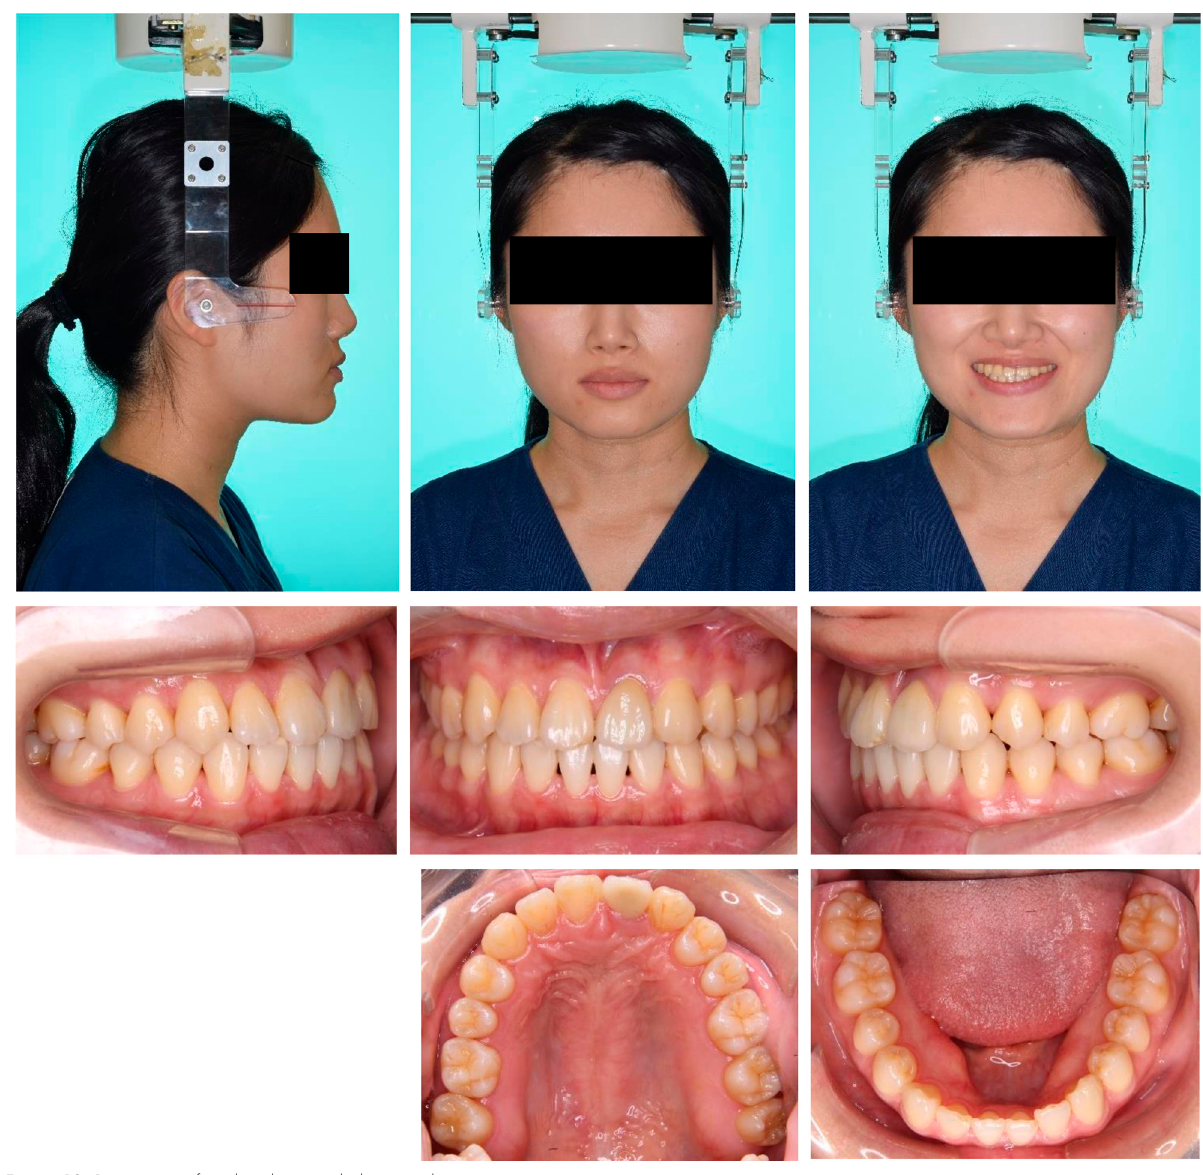
Figure 12. Postretention facial and intraoral